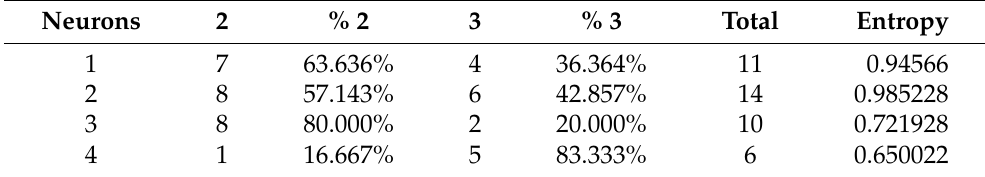
Table 2. Entropies and volumes of objects—level, 2 neuron